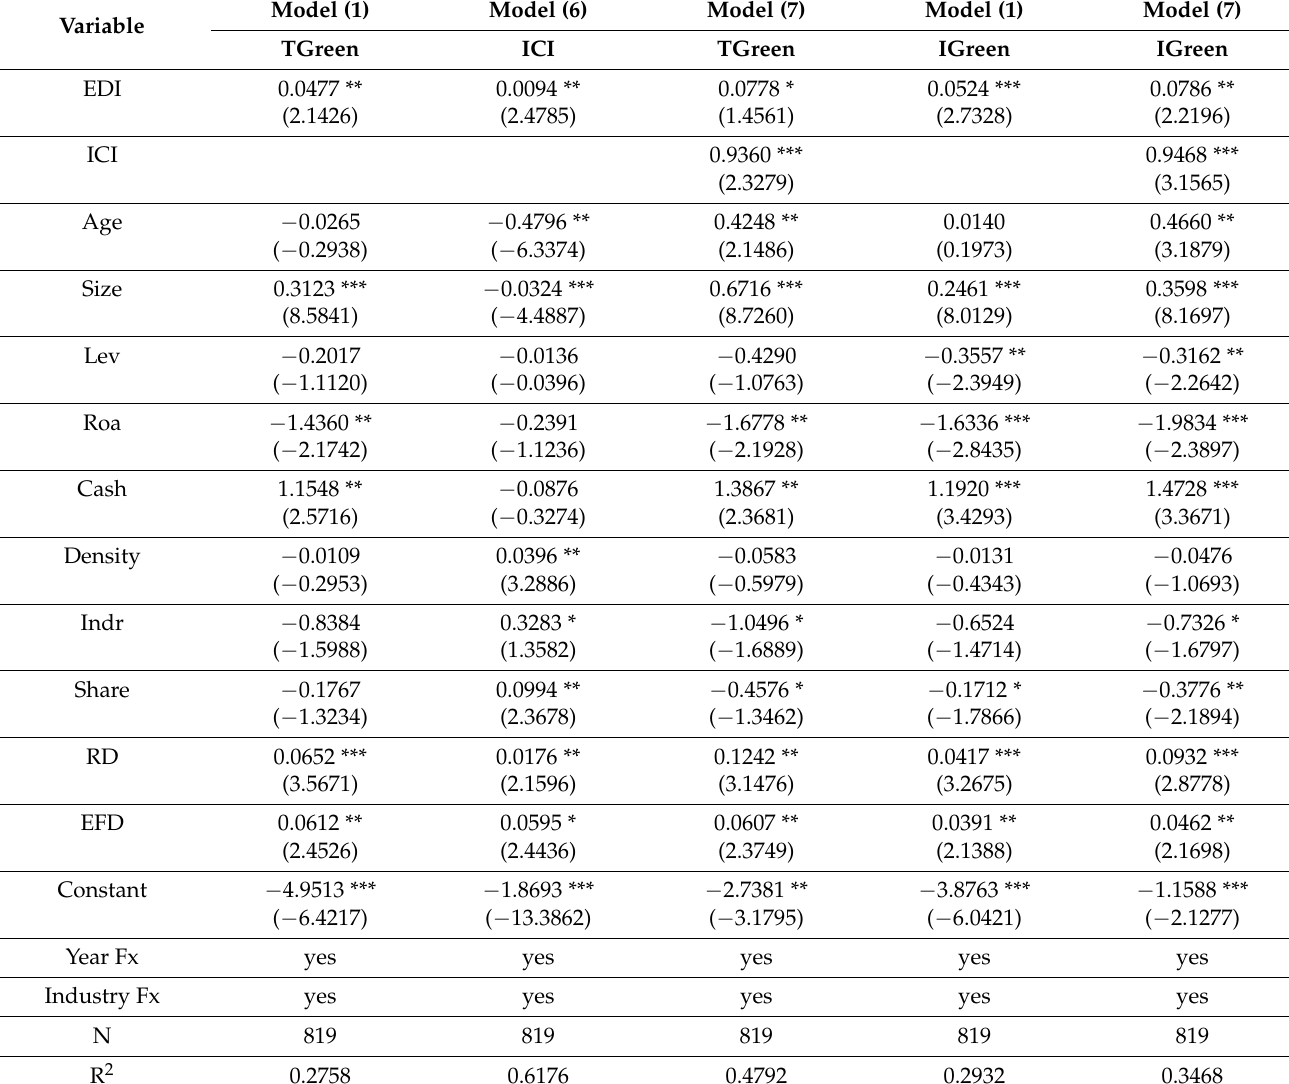
Table 7. Internal controls’ mediating